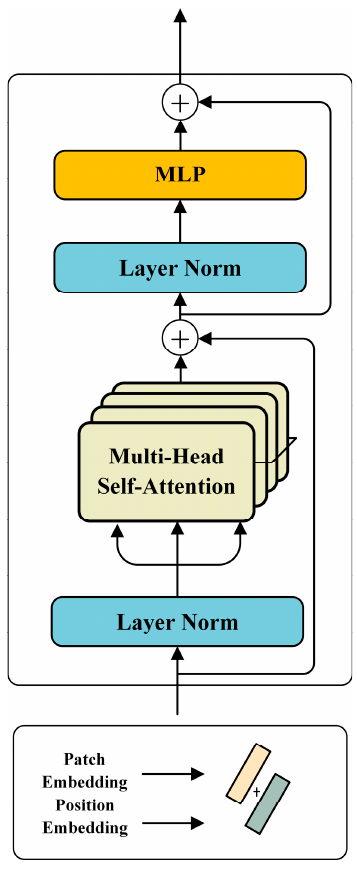
Figure 4. SETRnet’s transformer layer structure.